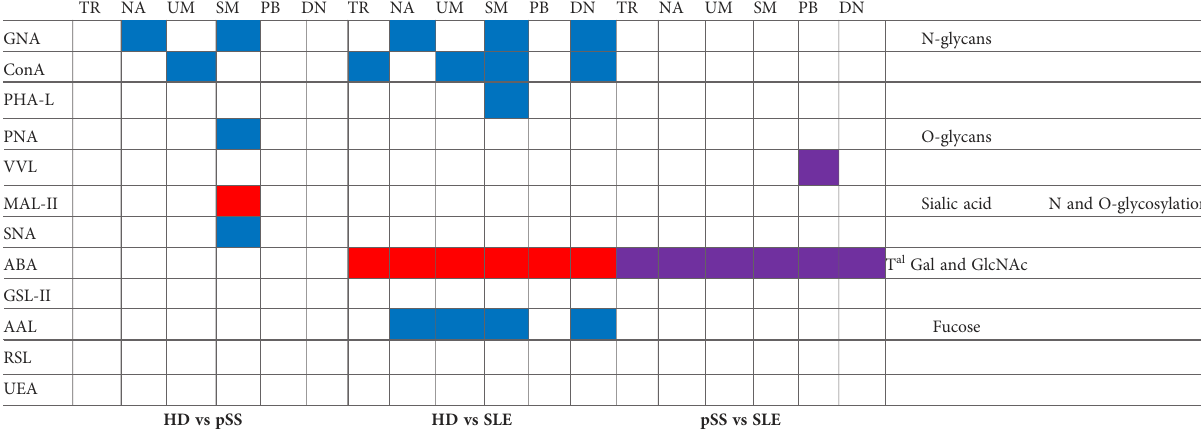
(Figure 6). This result supports the results obtained for the SLE B cells and their subsets. This suggests that there were some impairments in this same glycosylation pathway.